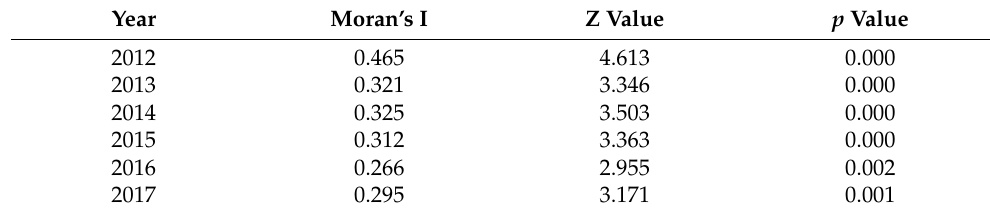
Table 4. Spatial correlation test of rural